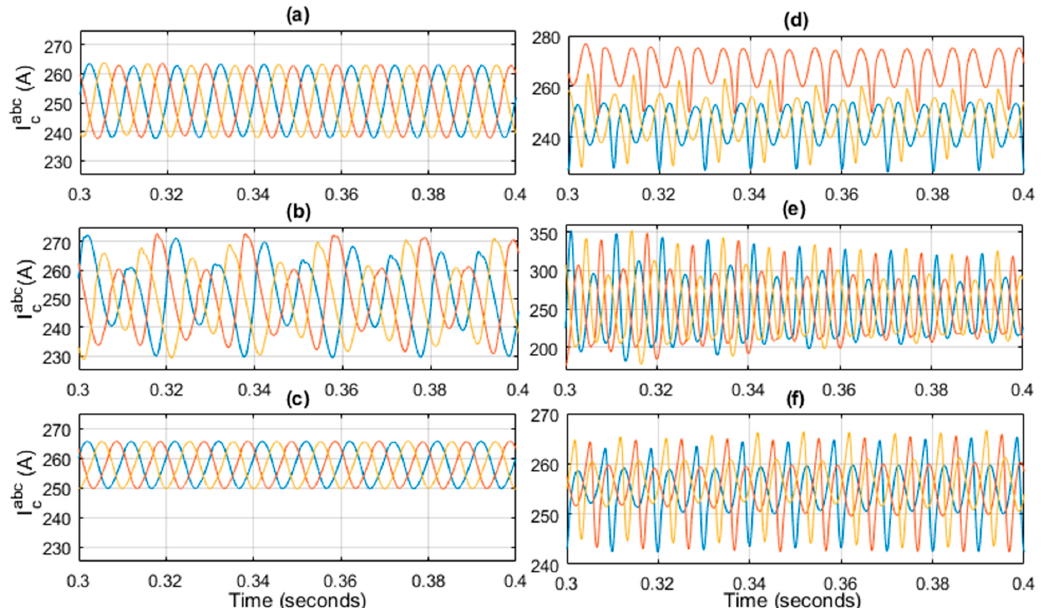
Figure 11. Circulating current at steady state ( a,b,c ) Backstepping controller; ( d,e,f ) PR controller; ( a,d ) L = 50 mH; ( b,e ) L = 25 mH; ( c,f ) L = 100 mH.